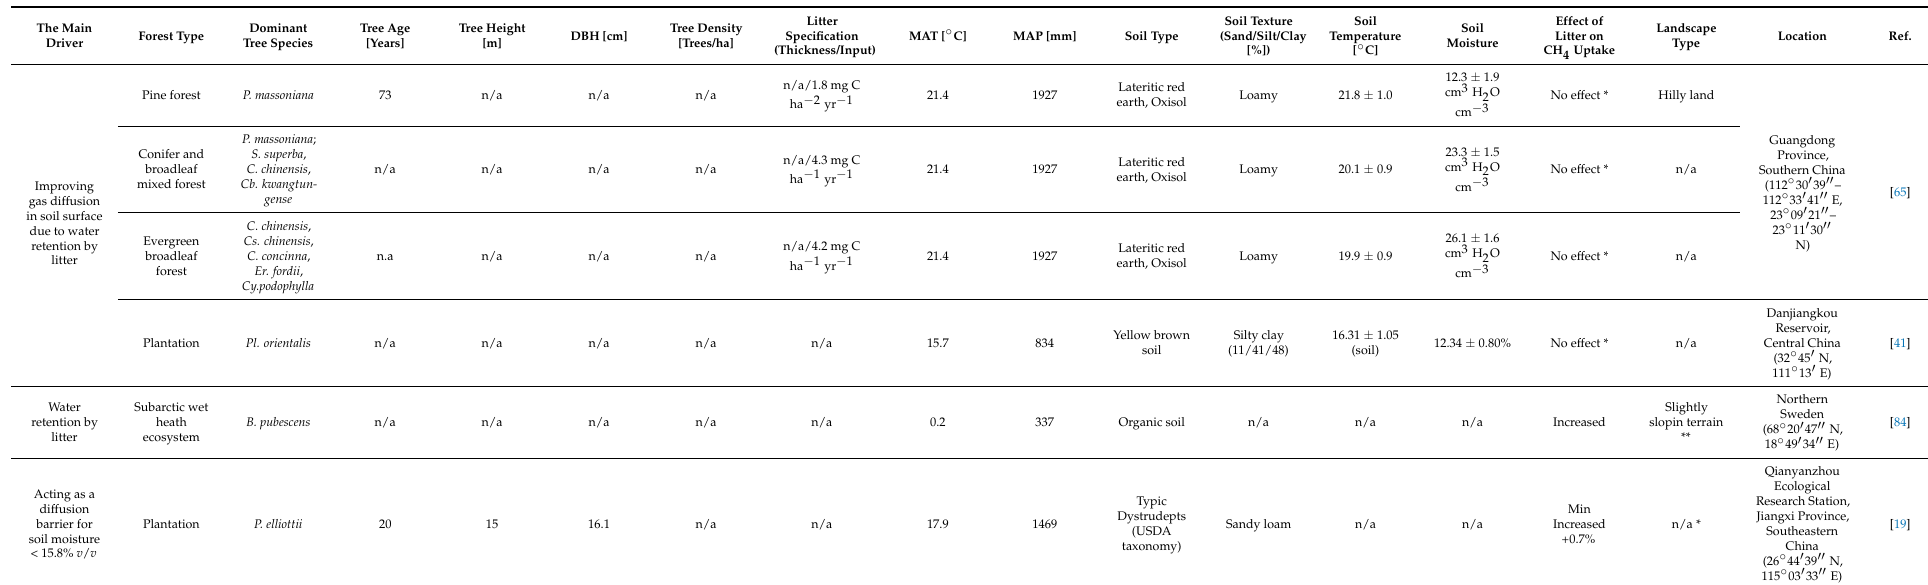
P.—Pinus; Pc.—Picea; Ab.—Abies; Fg.—Fagus; Pm.—Pometia; Br.—Barringtonia; Tr.—Terminalia; Tl—Tilia; Ul.—Ulmus; Cb.—Craibiodendron; Er.—Erythrophleum; Cy.—Cyathea; B.—Betula; DBH—diameter at breast height; n/a—data not available; Methods: * gas chromatography (GC); ** Ultraportable Greenhouse Gas Analyzer